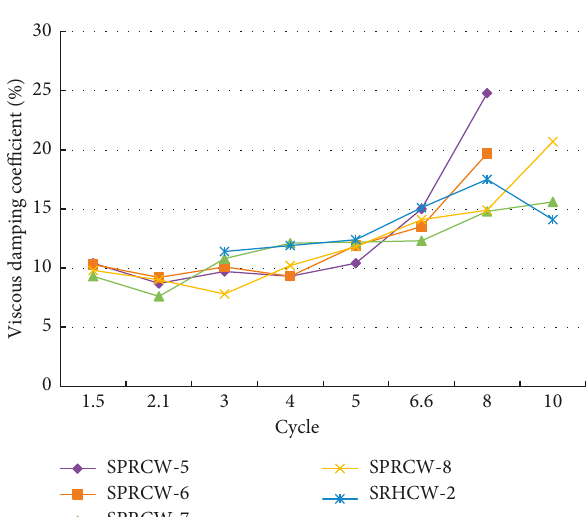
Figure 15: Comparison of equivalent viscous damping